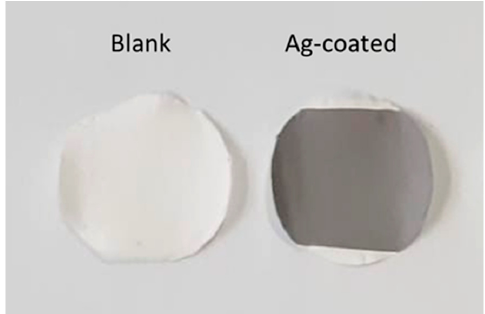
Some representative samples of electrospun DOE3 and DOE7 PSU disks before and after sputter-deposition of Ag are shown in Figure 4. after sputter-deposition of Ag are shown in Figure 4.